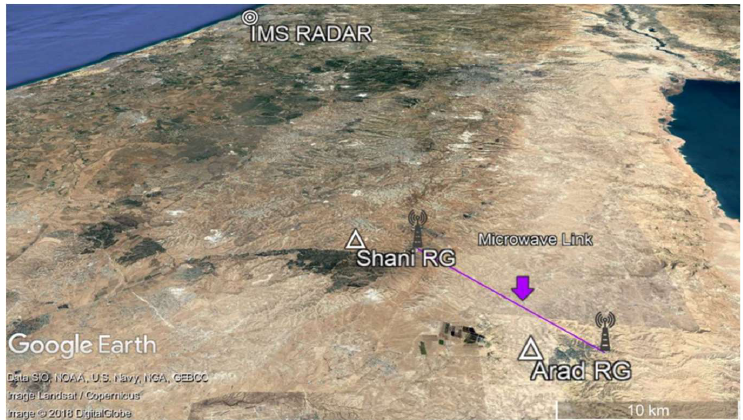
Figure 1. The experimental setup: the location of the weather radar, the CML, and the two Rain Gauges (Arad and Shani) are marked. This image is copied from [23], where the same experimental setup was used for a different purpose.